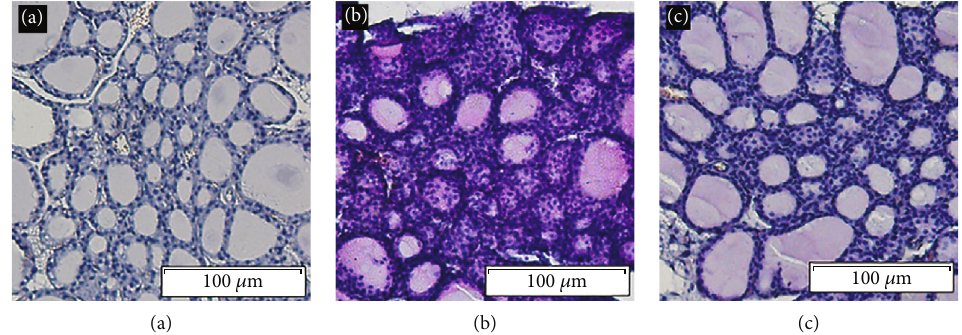
Figure 1: Representative thyroid sections from di ff erent groups ( HE × 200 ). (a) The NC group had a severity score of 0. (b) The EAT-A group had a thyroiditis score of 4+. (c) The EAT-B group had a thyroiditis score of